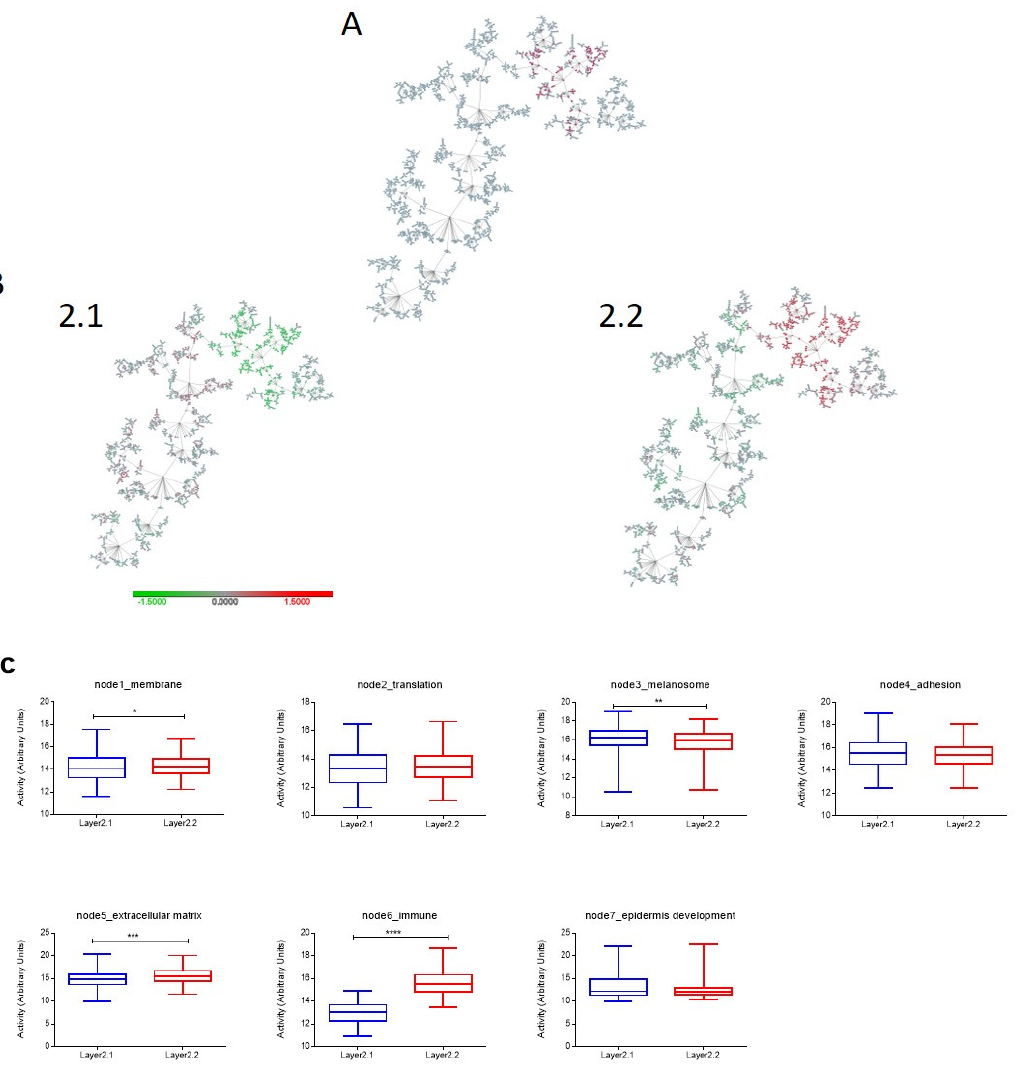
Figure 2. Second layer reflecting immune information in TCGA melanoma cohort. ( A ) Location of the 146 genes defining Layer 2 in the network. ( B ) Heatmap network of Layer 2 groups. ( C ) Comparison of functional node activities between defined groups. ****, p ≤ 0.0001; ***, p ≤ 0.001; **, p ≤ 0.01; *, p ≤ 0.05.